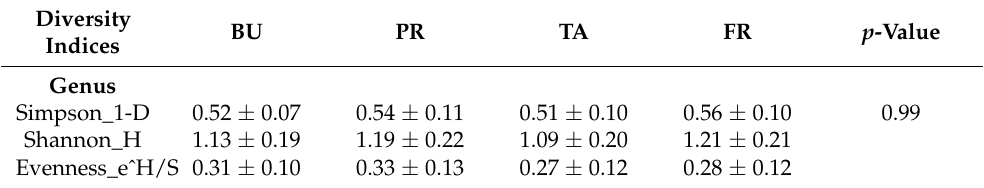
Figure 3. Heatmap showing list and relative abundance of nitrifying bacteria and archaea genera. Z-score with the scale bar shows the gradient of color saturation representing the relative abundance of the organisms. Table 3. Alpha diversity evaluation of nitrifying bacteria and archaea across different growth stages at genus